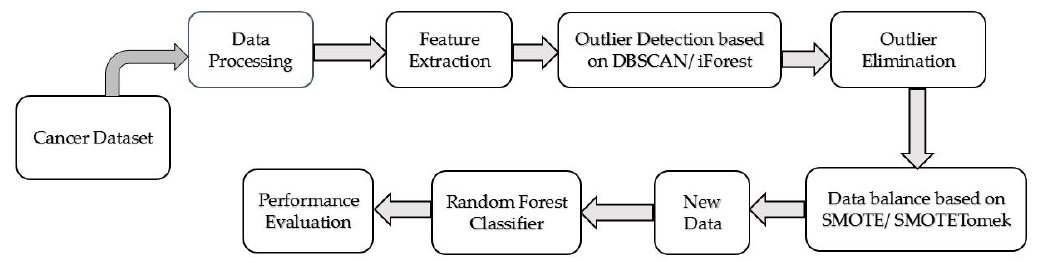
Figure 1. Prediction model for cervical cancer.